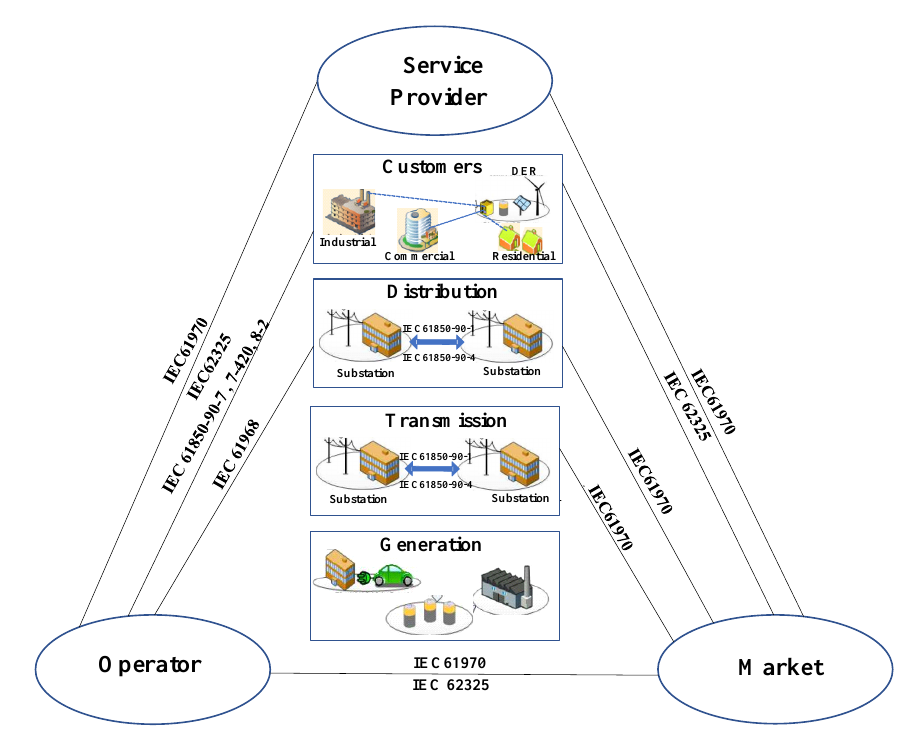
Figure 2. The smart grid conceptual model and its relevant standards.